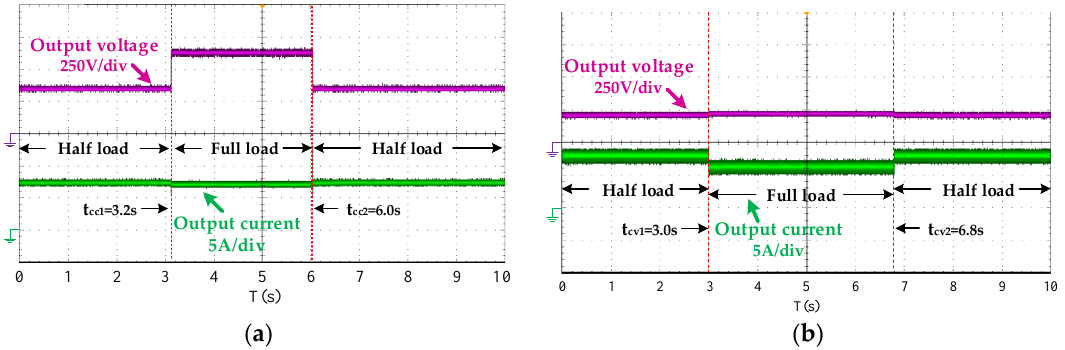
Figure 14. Output voltage and current of IPT system with ( a ) CC transmission mode and ( b ) CV transmission mode.